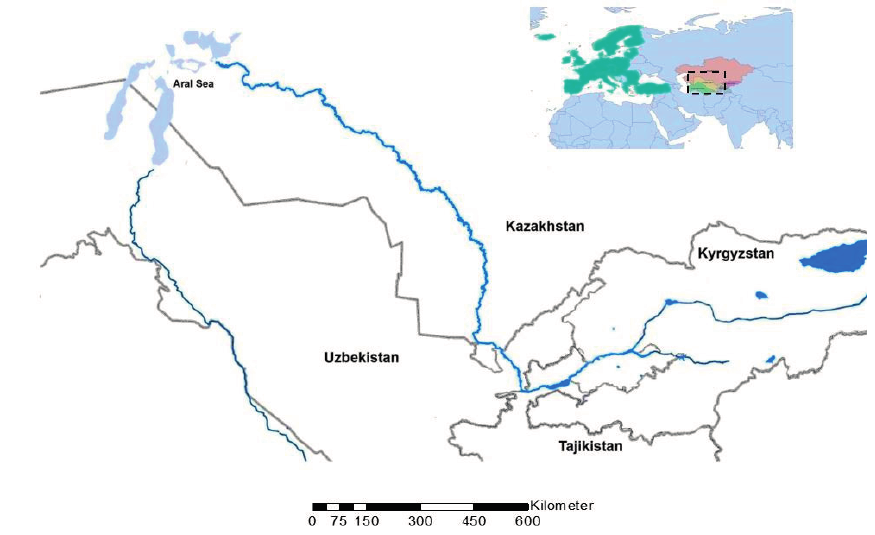
Figure 1. The Syr Darya